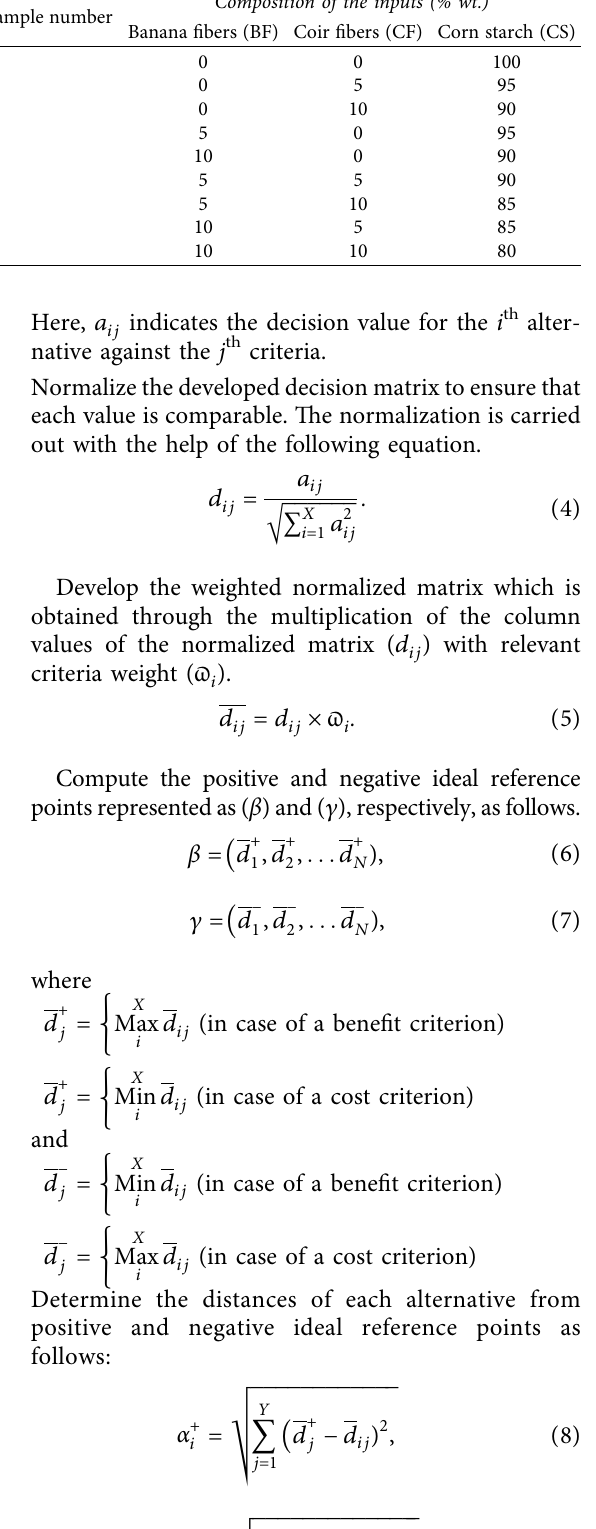
Table 1: Experimental design for sample manufacturing. Composition of the inputs (% Sample number